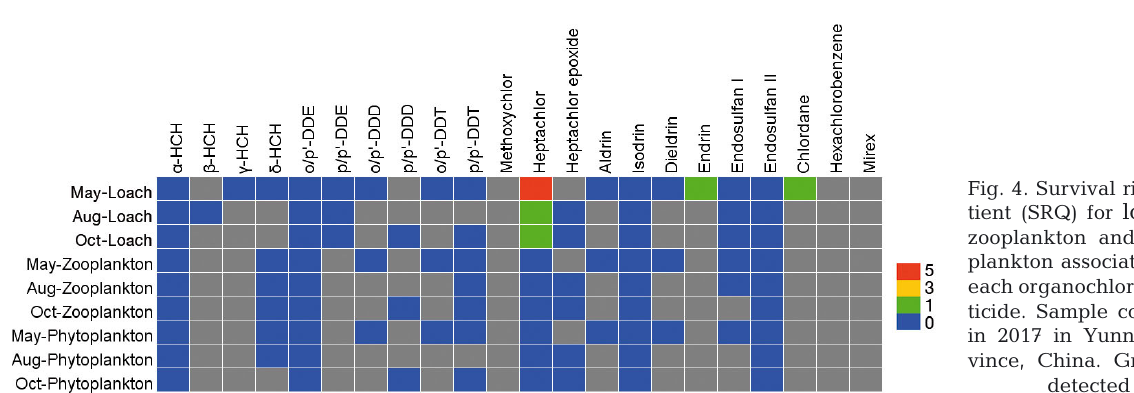
Fig. 4. Survival risk quo- tient (SRQ) for loaches , zooplankton and phyto- plankton associated with each organochlorine pes- ticide. Sample collection in 2017 in Yunnan Pro - vince, China. Gray: not